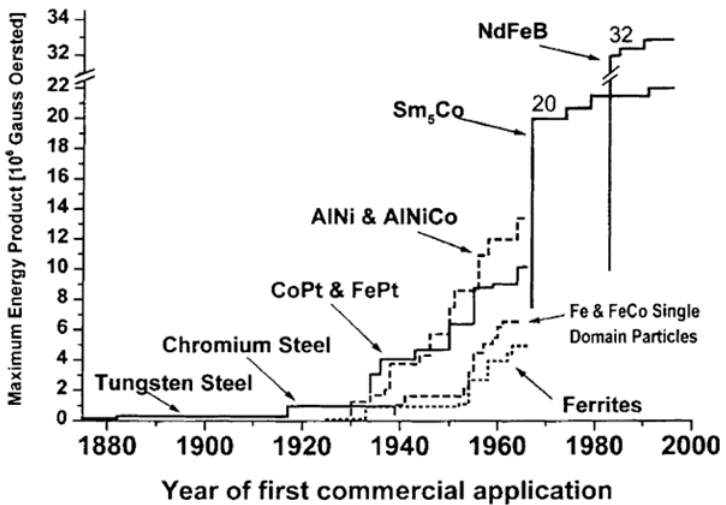
Figure 4. History of magnetic materials used in permanent magnetic separators [26].